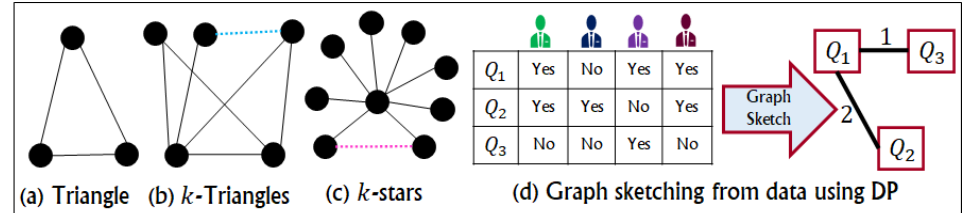
Figure 19. Overview of important statistics determined by DP model from G .